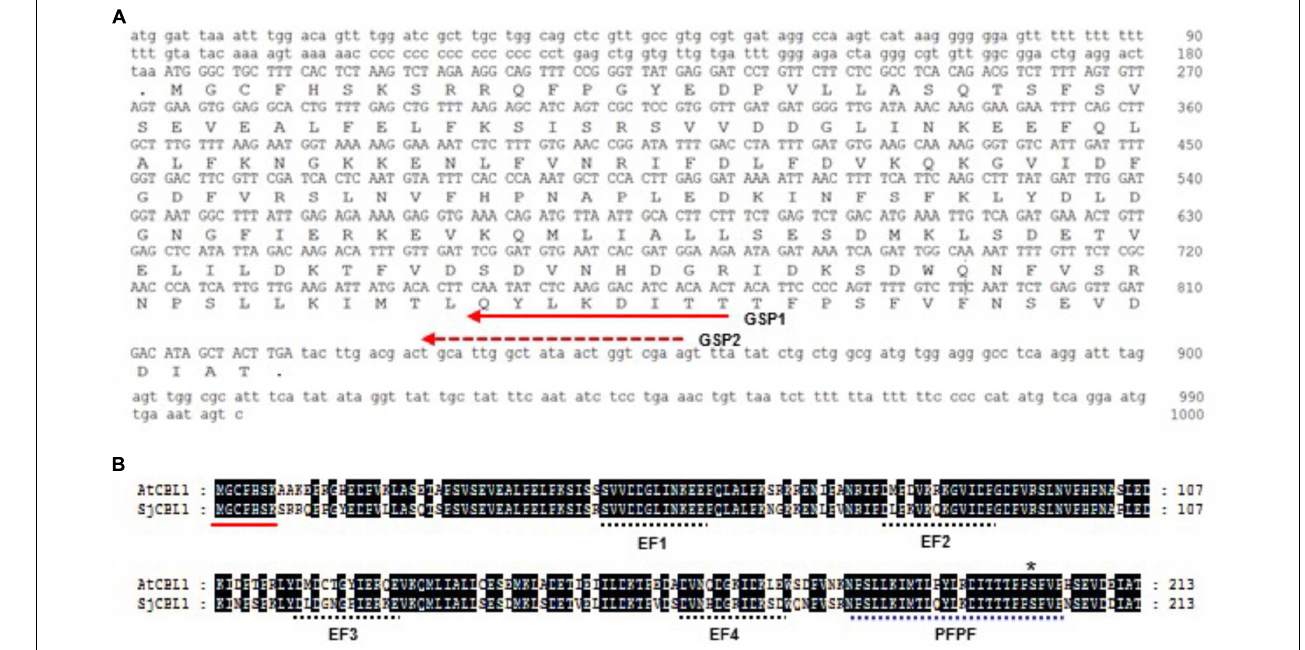
Frontiers in Plant Science |